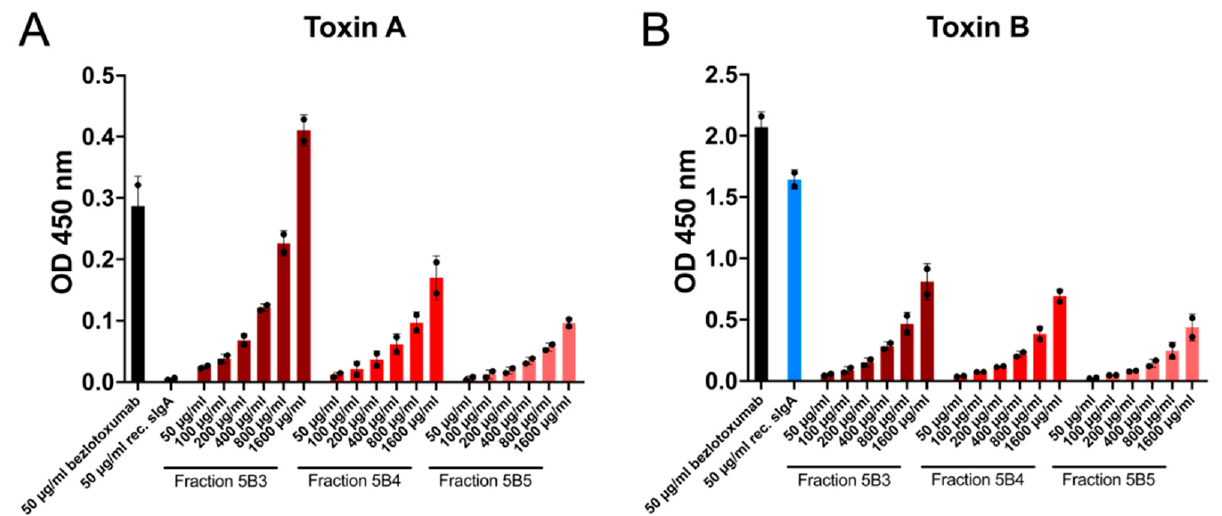
Figure 2. Neutralising potential of different antibodies against C. difficile toxin A (TcdA) and toxin B (TcdB). ( A ) All antibodies showed very low binding affinity to TcdA, with caprine whey sIgA fractions slightly increasing at higher concentrations. ( B ) Caprine whey sIgA fractions had a much lower binding potential against TcdB than bezlotoxumab and monoclonal recombinant sIgA. Data are represented as mean ± standard deviation (n = 2).